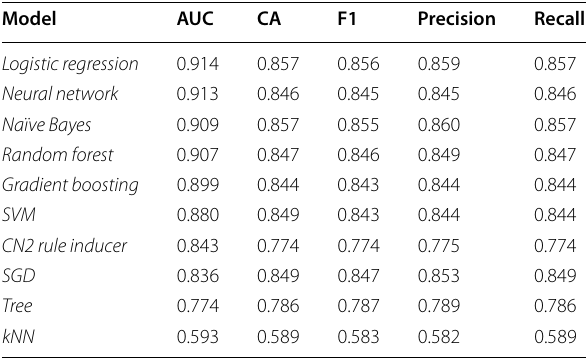
Table 2 Variables’ ranking results. Variables are listed from the most linked to the outcome to the least